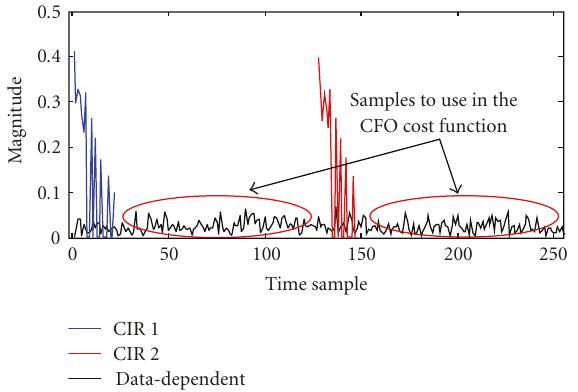
Figure 2: Example of the constitution of vector (cid:2) g .